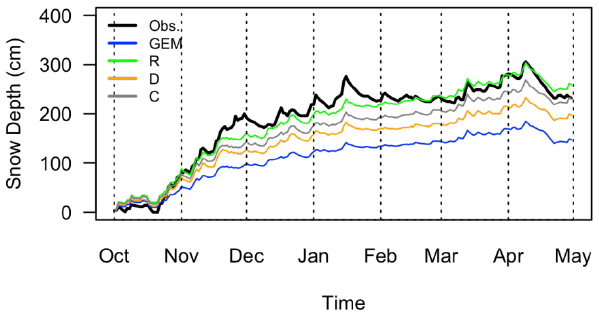
Fig. 2. Comparison of observed (black) and simulated snow heights Figure 2: Comparison of observed (black) and simulated snow heights using 52 using uncorrected (blue) and bias corrected (green, orange and grey) data. Replaces Fig. 3 of the original paper. uncorrected (blue) and bias corrected (green, orange and grey) data. Replaces 53 Figure 3 of the original paper. 54